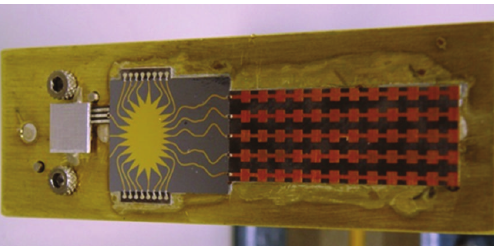
Figure 18: Complete test